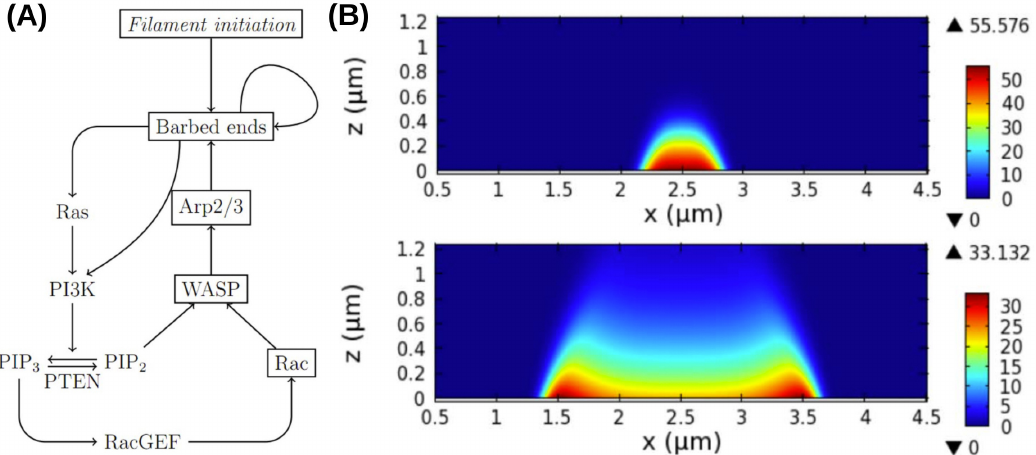
Figure 11. ( A ) A schematic of the network structure and molecular interactions in the model. ( B ) Two snapshots in time of an actin wave initiated at x = 2.5, showing the network density (color) as a function of space ( x -axis) and network height ( z -axis). From Khamviwath et al.